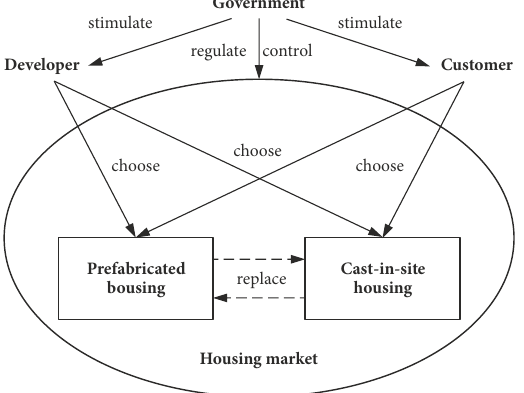
ing PH. Figure 1. Housing market for PH and